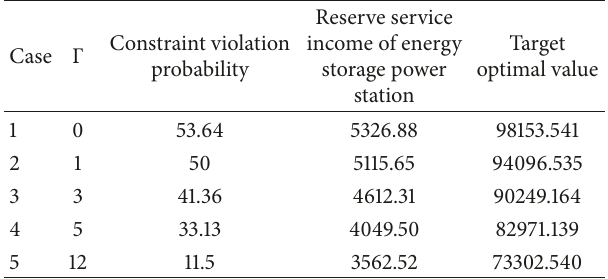
Table 3: Optimization results under different constraint violation